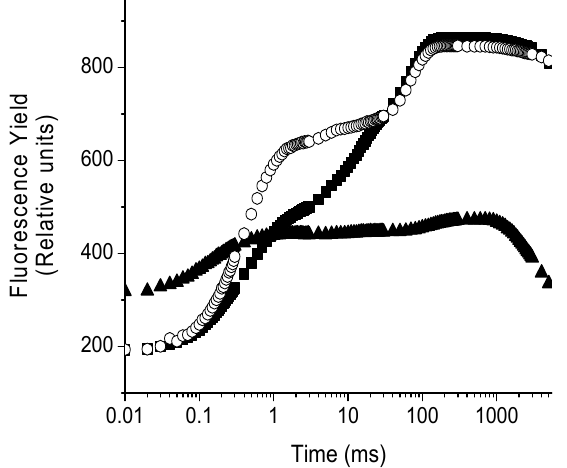
Figure 4. Fluorescence rise kinetic curves of P. ixocarpa leaves measured 72 h after treatment with 1 , 100 µg/mL (  ), control (  ) and 50 µM DCMU (  ). Data are an average of ten